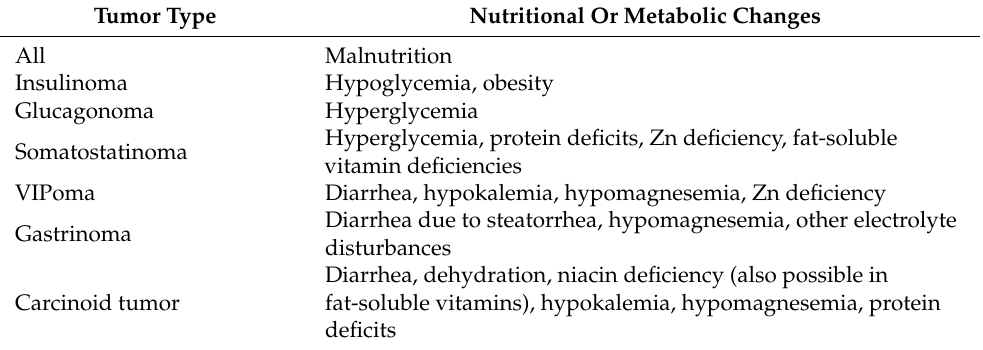
Table 9. Possible “specific” nutritional or metabolic alterations produced by digestive neuroen- docrine